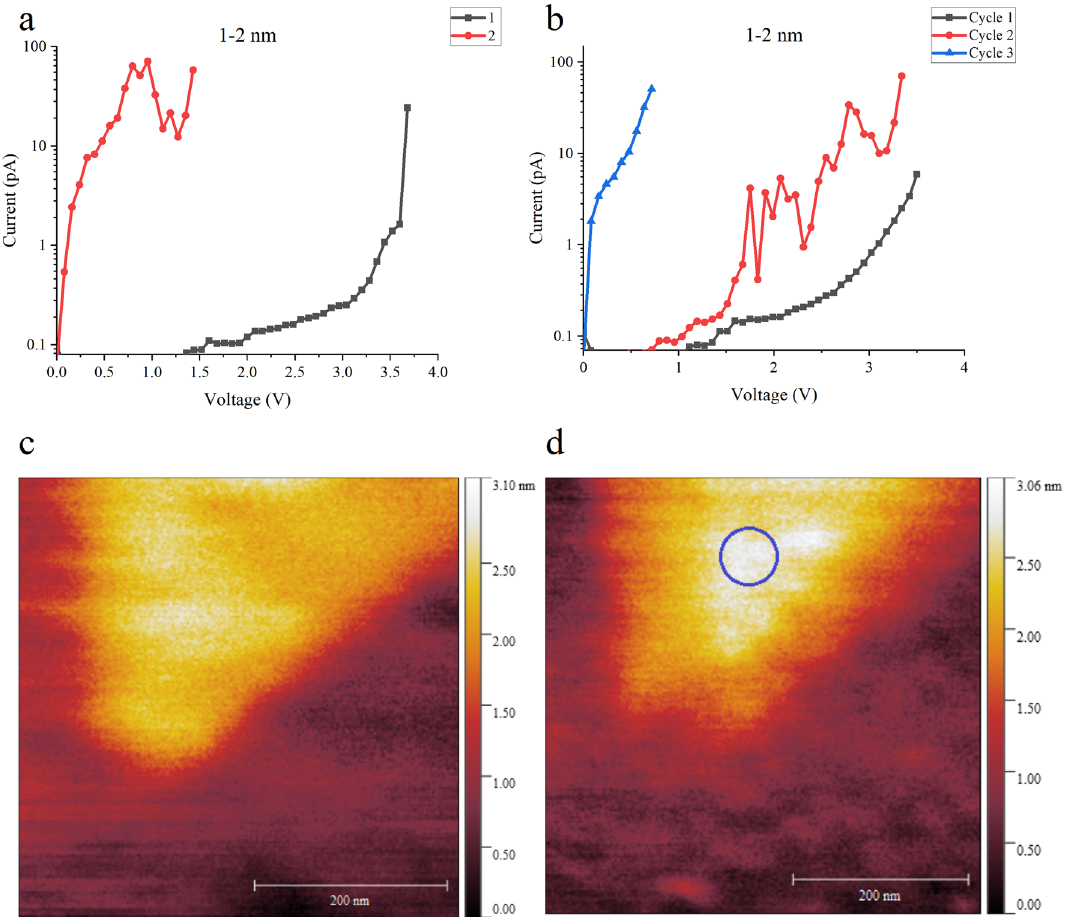
Figure 7. Breakdown data on very thin (1–2 nm) mica flakes, showing similar characteristics as for the thicker films. ( a ) BD experiment using standard RVS with 100 pA compliance, indicating V BD = 3.6 V. A diamond cantilever is used. ( b ) BD experiment using voltage limit RVS up to 3.5 V with 100 pA compliance, indicating a progressive degradation stage in the BD process. A diamond cantilever is used. Topography of the BD region ( c ) before and ( d ) after the BD measurement showing a slight swelling (circled) at the BD location. The swelling is 0.8 nm high.